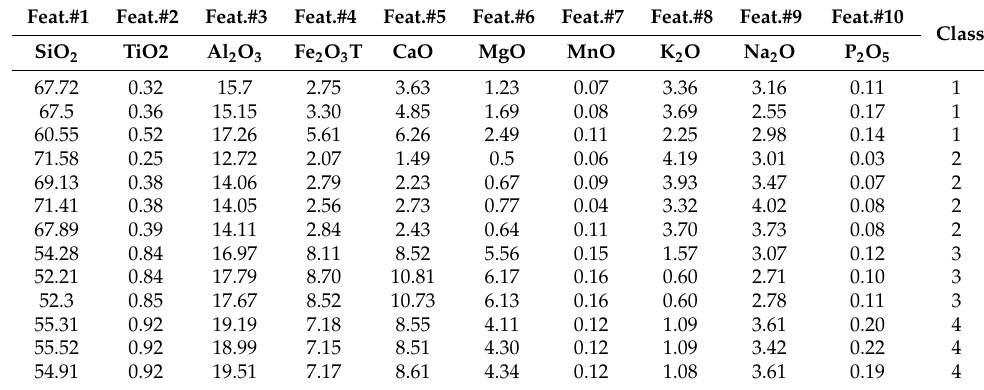
Figure 6. Na 2 O + K 2 O vs. SiO 2 diagram. Table 1. Snapshot of Dataset 1.